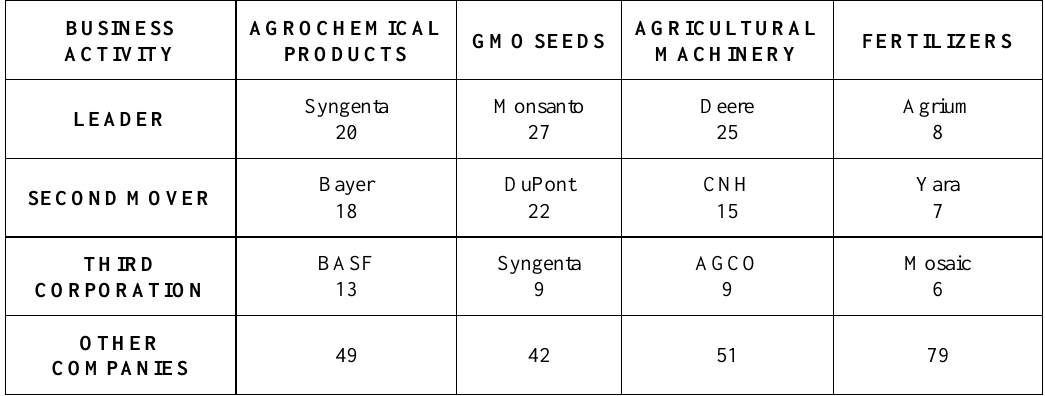
Table 1: Worldwide Agrochemical Corporations (Market Shares, % -